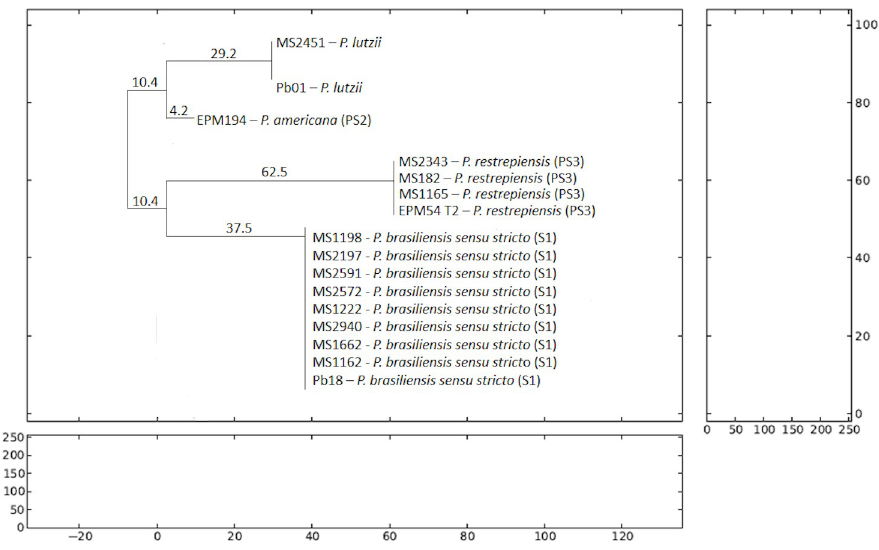
Fig 1. Phylogenetic analysis of tub 1 fragments generated by the PCR—RFLP technique of clinical and reference strains used in this study. The evolutionary method used to analyze the genetic distance between them was Neighbor Joining (NJ). Pb 01 (P. Lutzii ), MS2451 ( P . Lutzii ) and EPM194 ( P . americana (PS2)) were considered as species of close genetic variety and external group due to the phenomenon long branch attraction (LBA). Pb 18 ( P . brasiliensis sensu stricto (S1)) and EPM54 ( P . restrepiensis (PS3)) had similarity with the clinical isolates classified in their respective species and showing a common similarity between them.